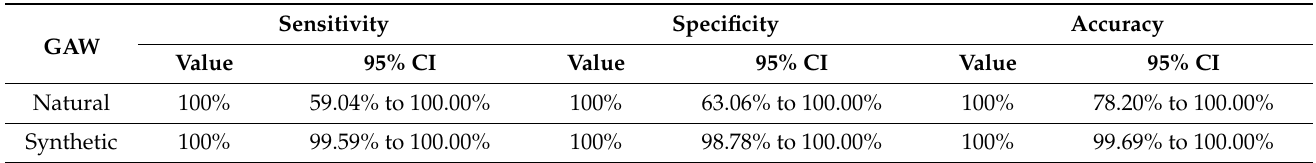
Table 1. Sensitivities, specificities and accuracies of classification between vocal fry and euphonic GAWs with 95% confidence interval